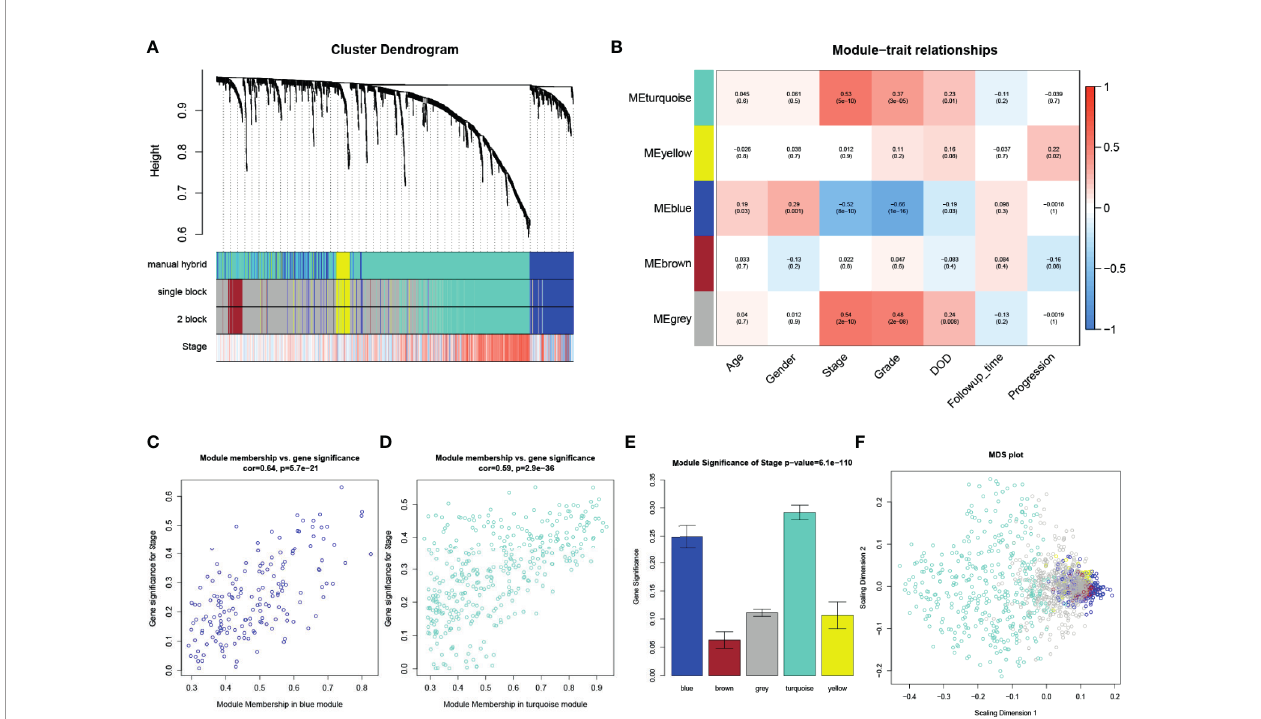
FIGURE 2 | WGCNA analysis. (A) The cluster dendrogram of genes in GSE32548. Each branch in the fi gure represents one gene, and every color below represents one co-expression module. (B) Heatmap of the correlation between module eigengenes (MEs) and different clinical information of BC (age, gender, pathological stage, grade, DOD (death of disease), follow-up time, and progression). (C) Scatter plot of module eigengenes in the blue module. (D) Scatter plot of module eigengenes in the turquoise module. (E) Distribution of average gene signi fi cances and errors in the modules associated with the pathological stage of BC. (F) Classical MDS plot whose input is the TOM dissimilarity. Each dot (gene) is colored by the module